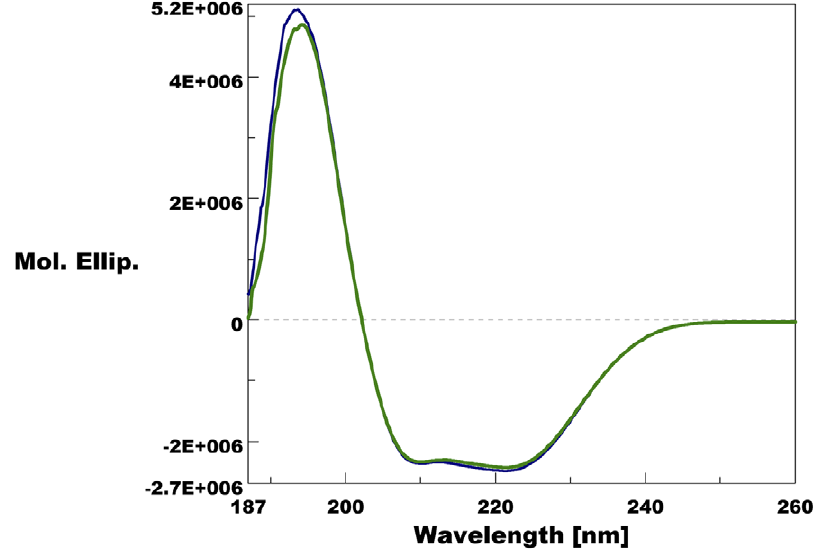
Figure 4. Far UV circular dichroism spectra of purified recombinant PregOBP56a. A positive peak of the CD spectra at 194 nm and two negative peaks at 209 and 221 nm are observed at pH 7 and pH 5, indicating that PregOBP56a is an a -helix-rich protein as other insect